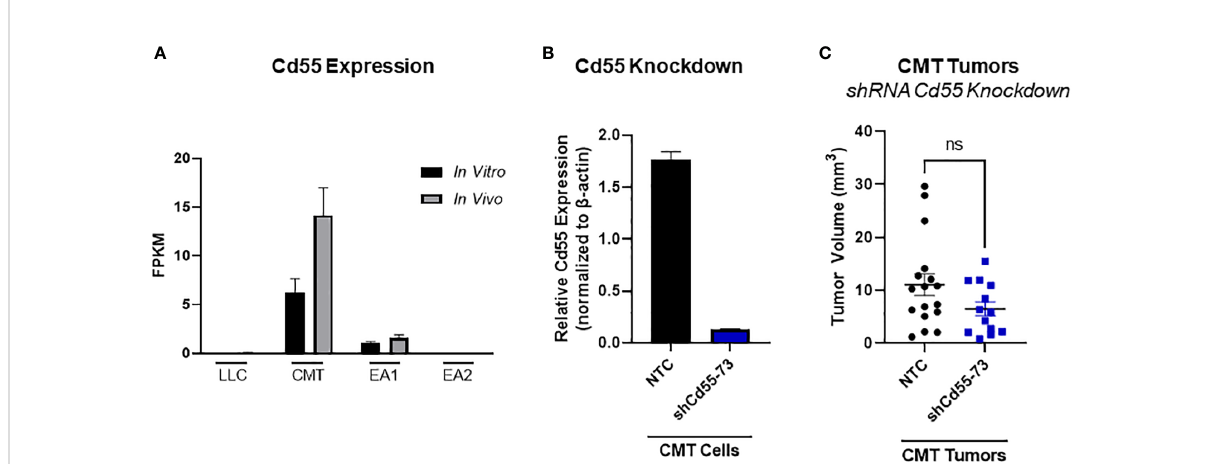
FIGURE 5 Role of CD55 on tumor progression. (A) Expression of complement regulatory protein CD55 from RNA-seq data comparing in vivo and in vitro samples in all 4 cell lines, where in vivo samples appear to induce expression compared to the in vitro cells. Data presented as FPKM values. (B) Ef fi ciency of shRNA knockdown for CD55 in CMT cells. Pools of cells transfected with either shRNA targeting CD55 or non-targeting control (NTC) were analyzed for expression of CD55 by qRT-PCR. (C) 250K CMT cells silenced for CD55 or control cells were implanted into the left lung of C57Bl/6 mice. Tumor were harvested at 2 weeks post implantation and tumor volume was assessed via digital calipers. Graph is combined of 2 independent experiments. N=7-9 per group per experiment. 2 outliers were removed using the ROUT test where Q=1%; a nonparametric Mann-Whitney was performed; ns, not signi fi